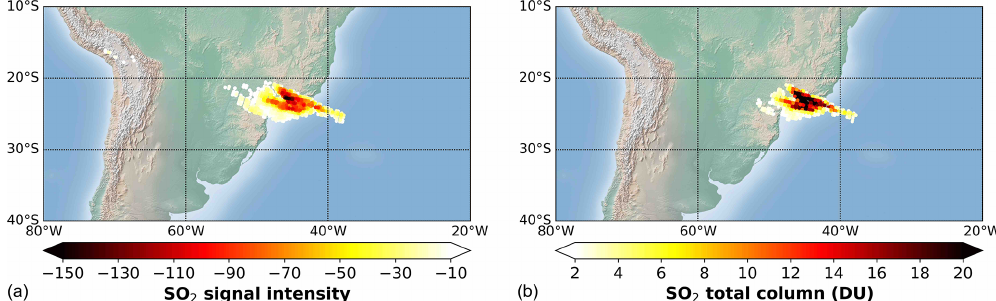
Figure 5. (a) Spatial distribution of the residual values associated with SO 2 IASI-PCA-GE detections, using IASI/Metop-B radiance data recorded on 20 July 2019 in the morning (daytime or AM orbit). (b) SO 2 total column retrievals in Dobson